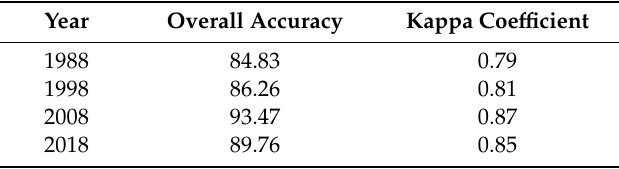
Table 2. Accuracy assessment results from 1988 to 2018.